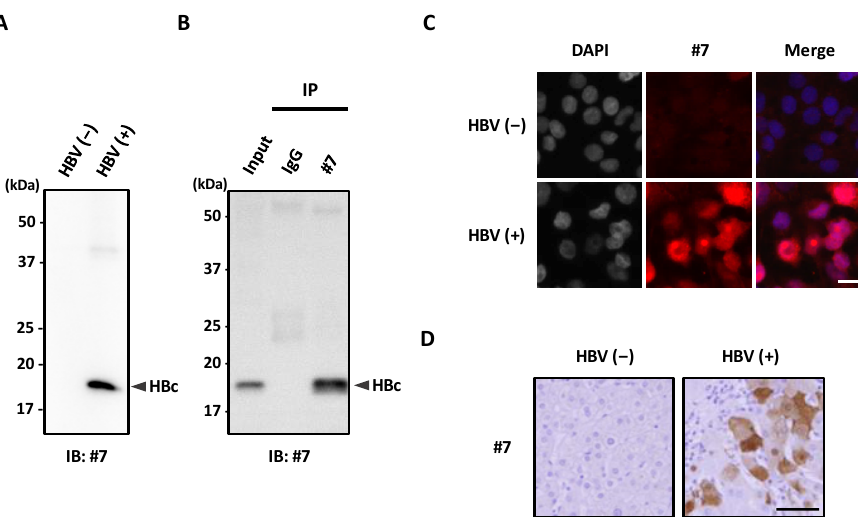
Figure 2. The newly developed mAb #7 detects HBc in HBV-infected cells. ( A ) Lysates of HepG2 cells (HBV ( − )) or HepG2.2.15.7 cells (HBV (+)) were analyzed by immunoblotting with mAb #7. ( B ) HepG2.2.15.7 cell lysates were immunoprecipitated with mAb #7, then bound proteins were analyzed by immunoblotting with mAb #7. ( C ) HepG2 cells (HBV ( − )) and HepG2.2.15.7 cells (HBV (+)) were fixed with 4% PFA and then stained with mAb #7 (red) and DAPI (blue). Scale bar, 10 µ m. ( D ) HBV negative ( − ) and positive (+) paraffin-embedded human liver tissues were stained with mAb #7 using peroxidase conjugate and DAB chromogen, and then counterstained with hematoxylin. Scale bar, 100 μ m.